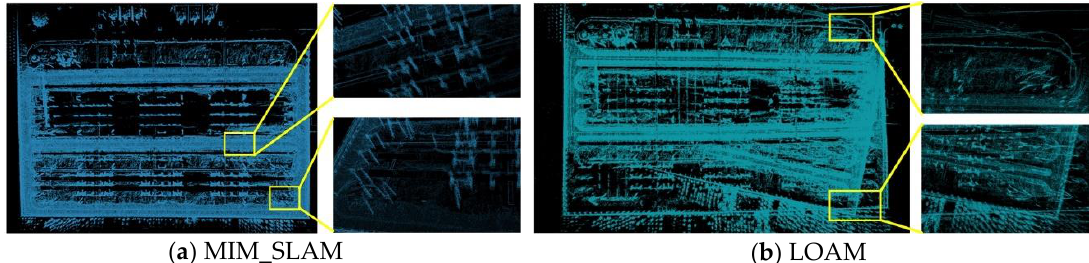
Figure 9. The point cloud maps established by the MIM_SLAM and the LOAM algorithms.